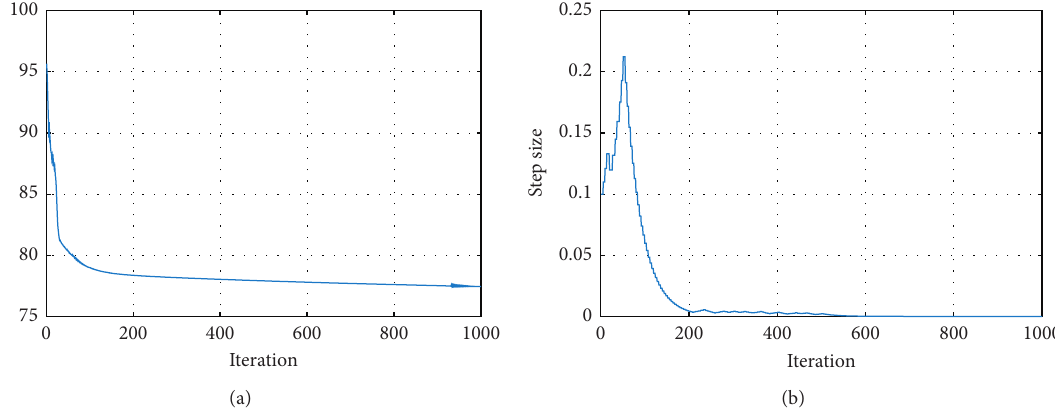
Figure 5: Cost functions: root mean square error (a) and step size (b), as a function of iteration.